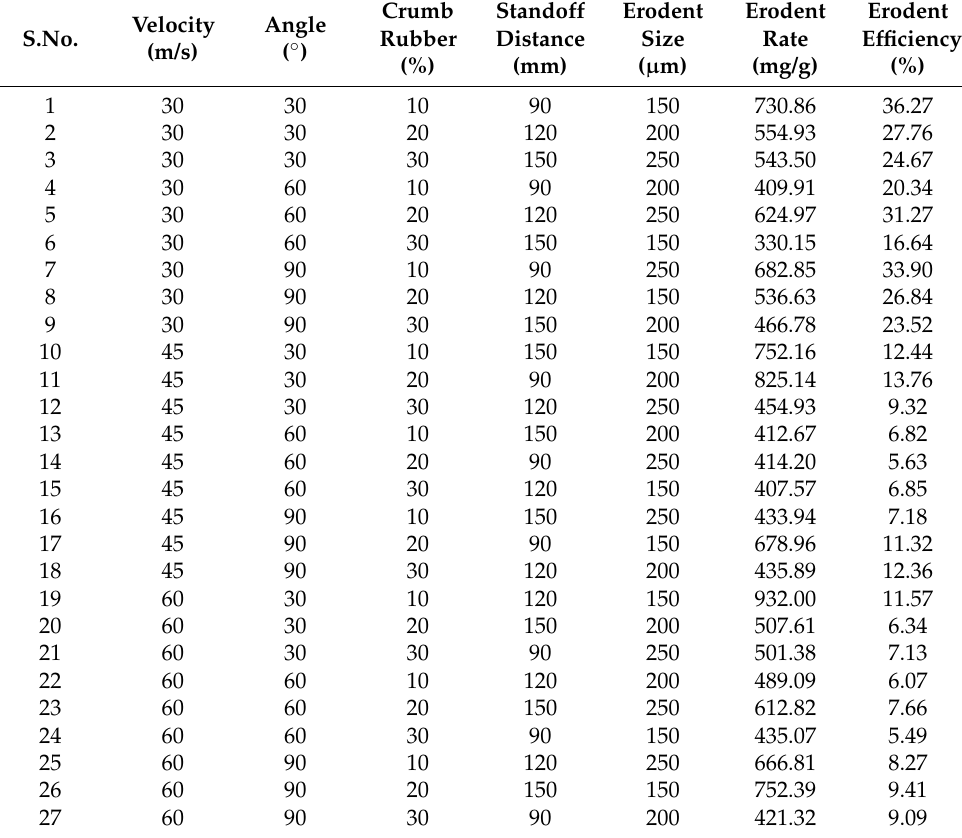
Table 2. Experimental design and response